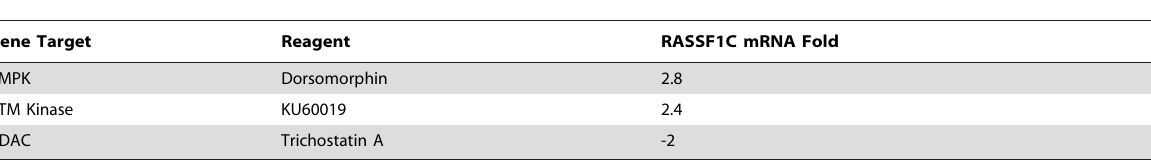
Table 1. PCR array screen.